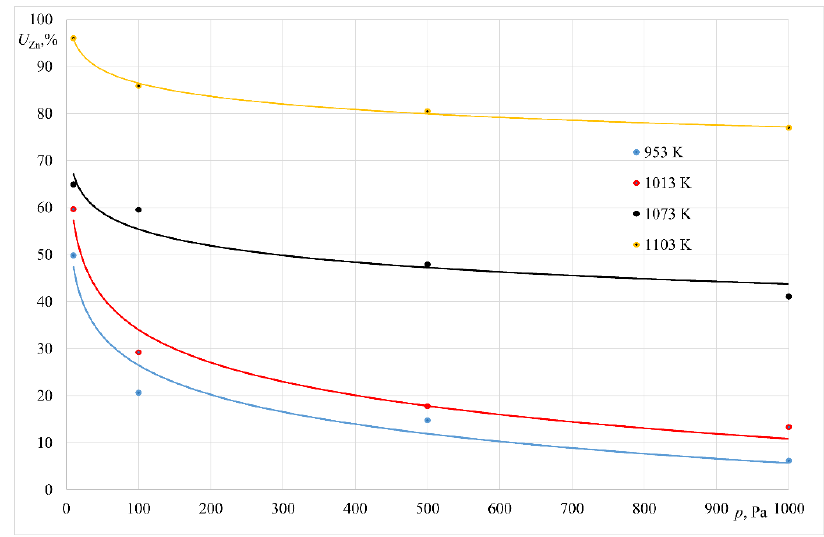
Figure 5. Relative zinc mass loss for the experiments performed in the crucible furnace.